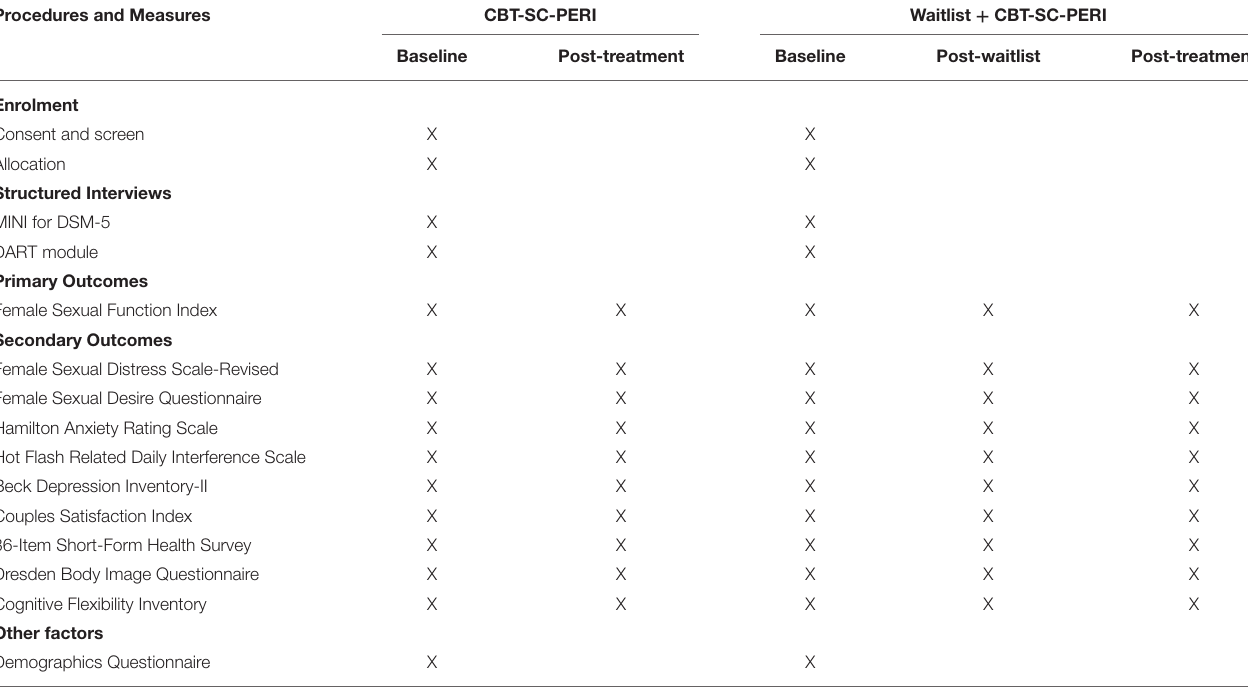
TABLE 1 | Timing of